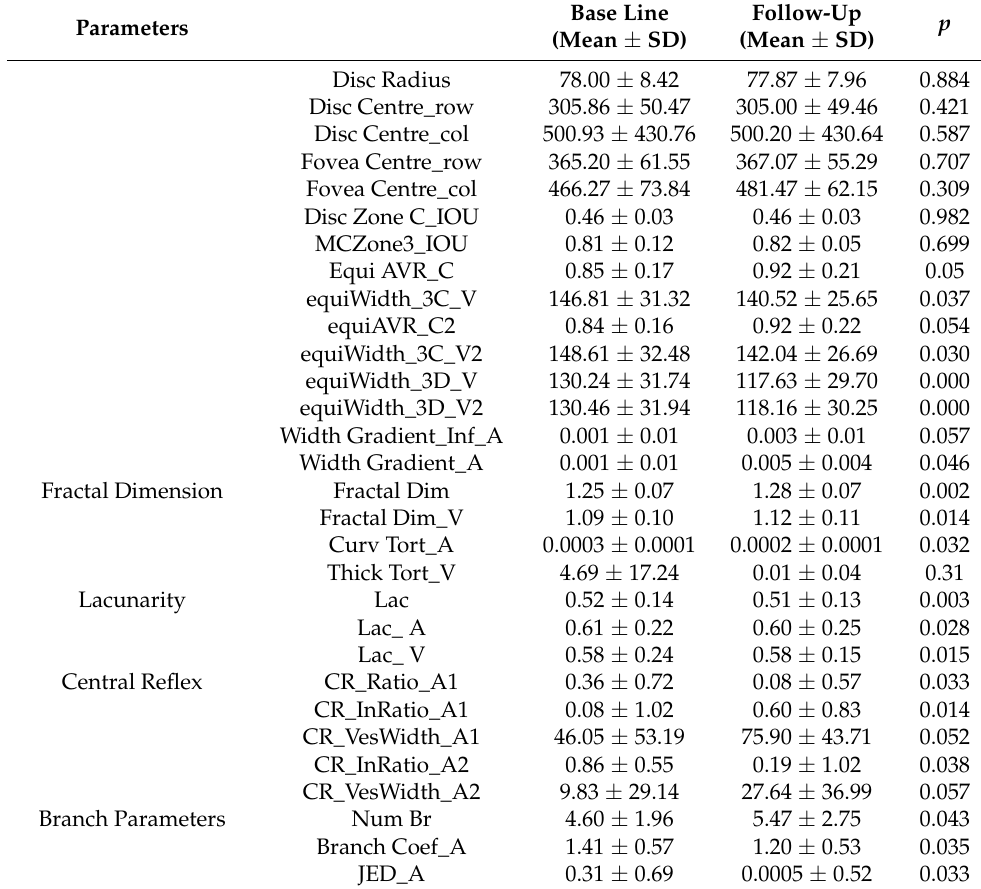
Table 3. The differences in parameters at baseline and 4-year